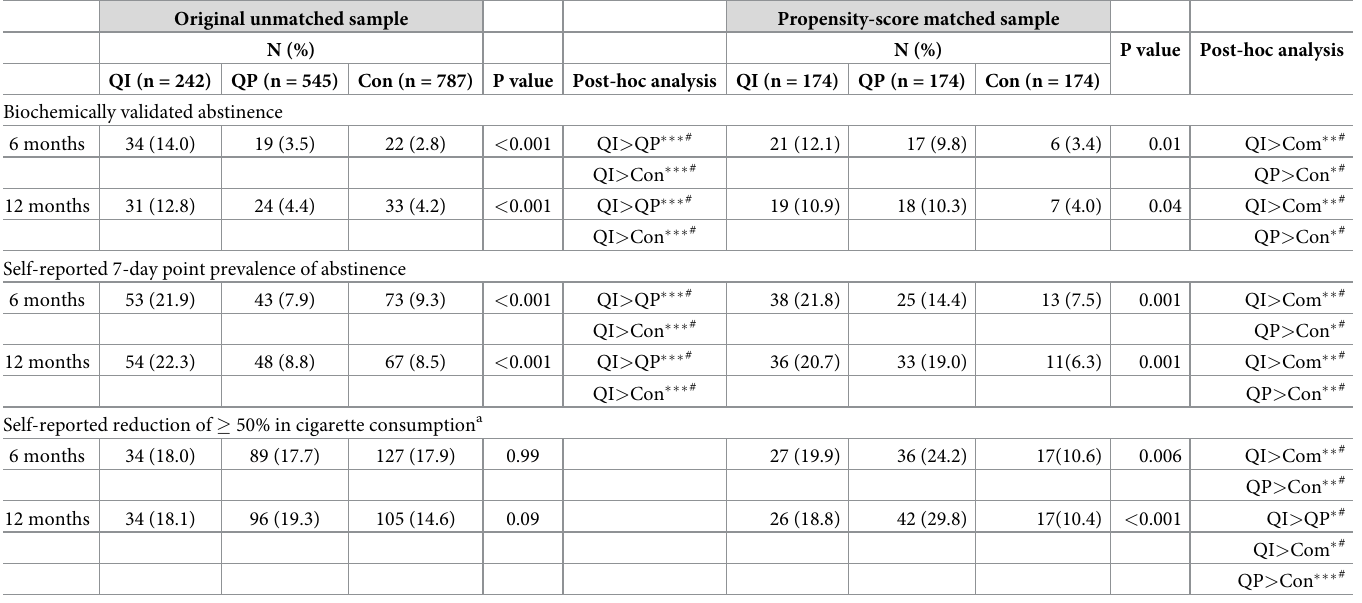
Table 3. Cessation outcomes of subjects in the Quit Immediately (QI) group, Quit Progressively group and control group in the original unmatched sample and the propensity-score matched sample. Original unmatched sample Propensity-score matched